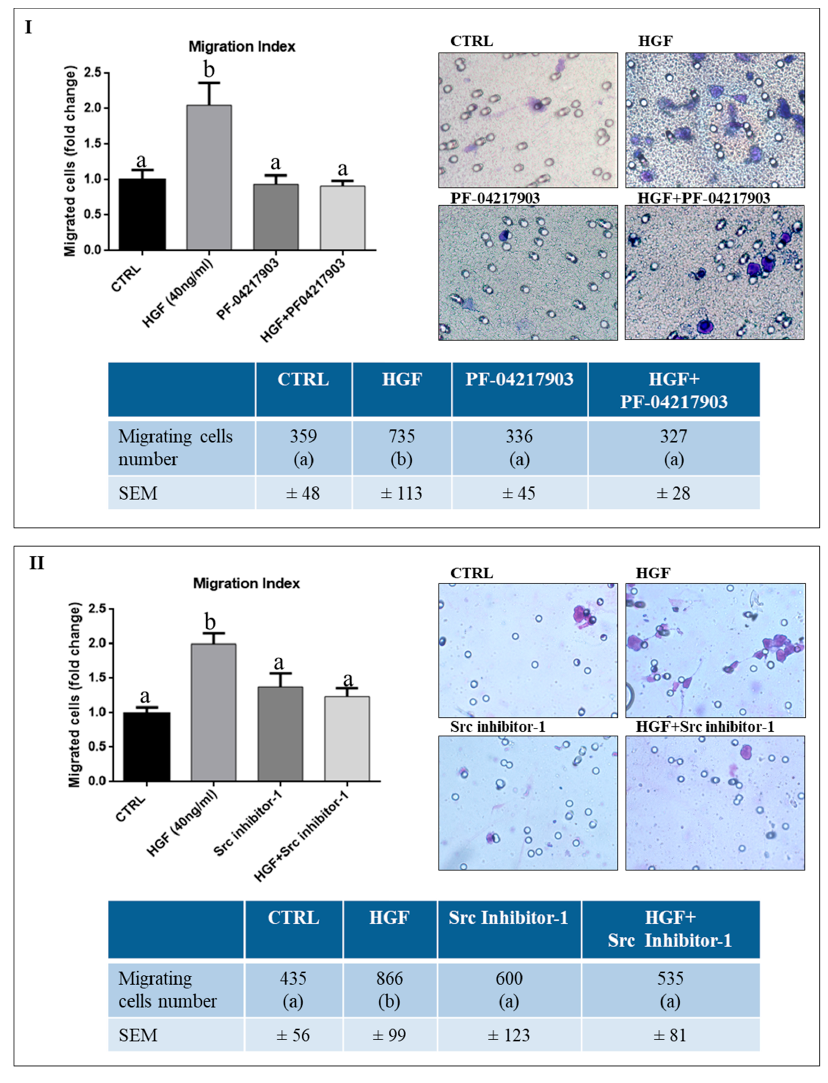
Figure 2. Effect of PF-04217903 and Src Inhibitor-1 on HGF-dependent NT2D1 cell chemotaxis. All experiments were performed at least in quadruplicate. ( I ) Effect of c-MET inhibitor (PF-04217903). Left panel: Graphical representation of the amount of chemo-attracted NT2D1 cells. HGF significantly increases cell migration. C-MET inhibitor (PF-04217903) administration abrogates the migratory effect induced by HGF, even if this drug is not able to affect NT2D1 cell migration when administered alone. The values of treated samples were reported as fold-change compared with control values (arbitrarily considered as 1) (b vs. a p < 0.001). Right panel: Representative bright-field microscopy images (40 × magnification) of the filters with the NT2D1 migrated cells. Lower panel: Table illustrating the real number of migrating cells/filter in all the experimental conditions reported in the respective “fold-change” graph (b vs. a p < 0.001). ( II ) Effect of Src inhibitor-1. Left panel: Graphical representation of the amount of chemo-attracted NT2D1 cells. Src inhibitor-1 abrogates the chemotactic effect induced by HGF, even if this drug is not able to affect NT2D1 cell migration when administered alone. The values of treated samples were reported as fold-change compared with control values (arbitrarily considered as 1) (b vs. a p < 0.001). Right panel: Representative bright-field microscopy images (40 × magnification) of the filters with the NT2D1 migrated cells. Lower panel: Table illustrating the real number of migrating cells/filter in all the experimental conditions reported in the respective “fold change” graph (b vs. a p <